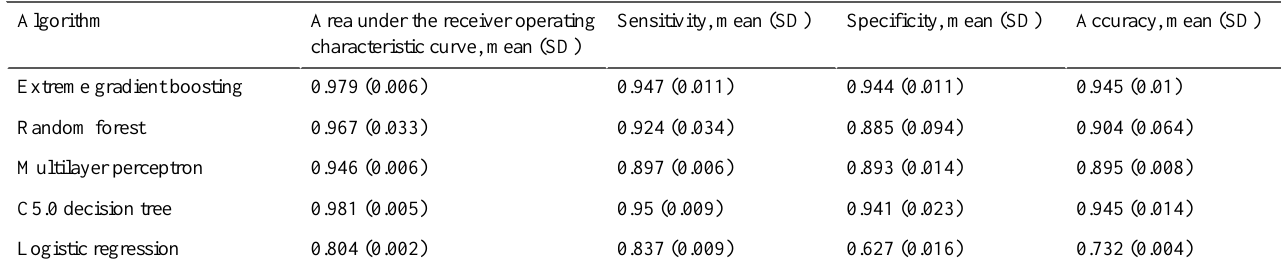
Table 4. Performance of the 5 machine learning models on predicting language understandability of the health texts for international students in tertiary